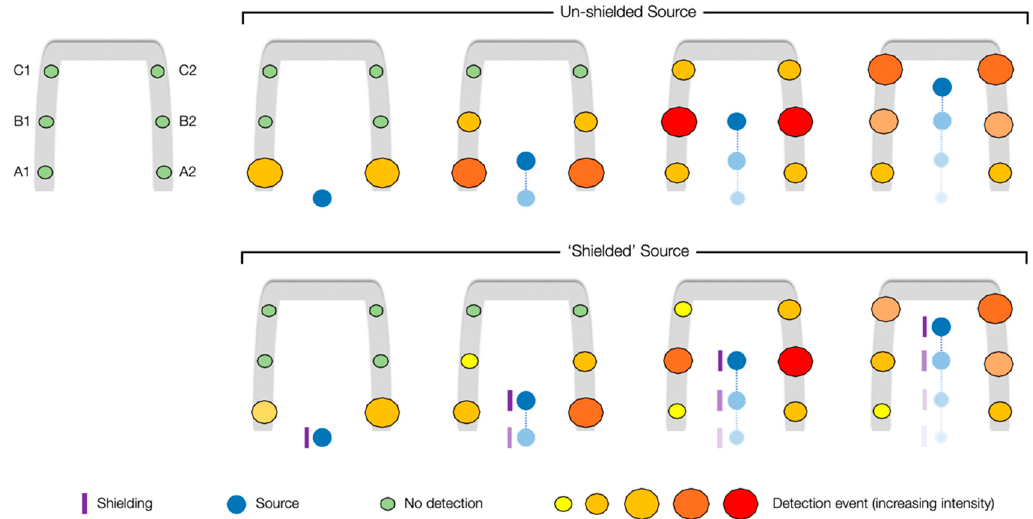
Figure 5. Graphical representation of a radioactive source (unshielded and “shielded”) transiting through the Speed Gate™, inducing elevated count rates on the GM detectors as it moves.